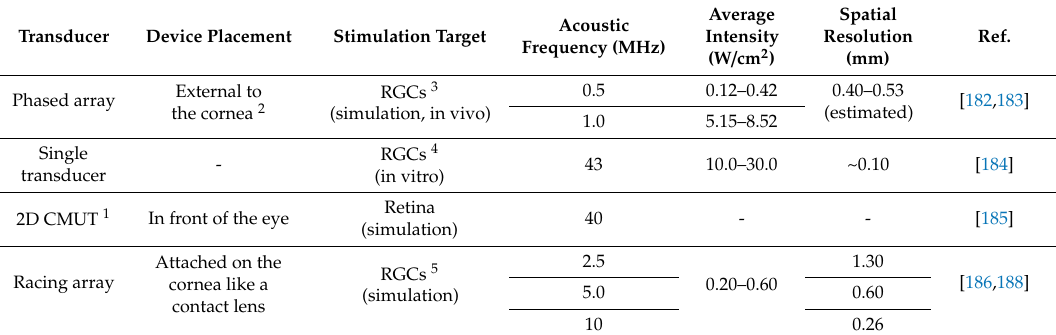
Table 3. A summary of prosthetic uses of focused ultrasound in retinal